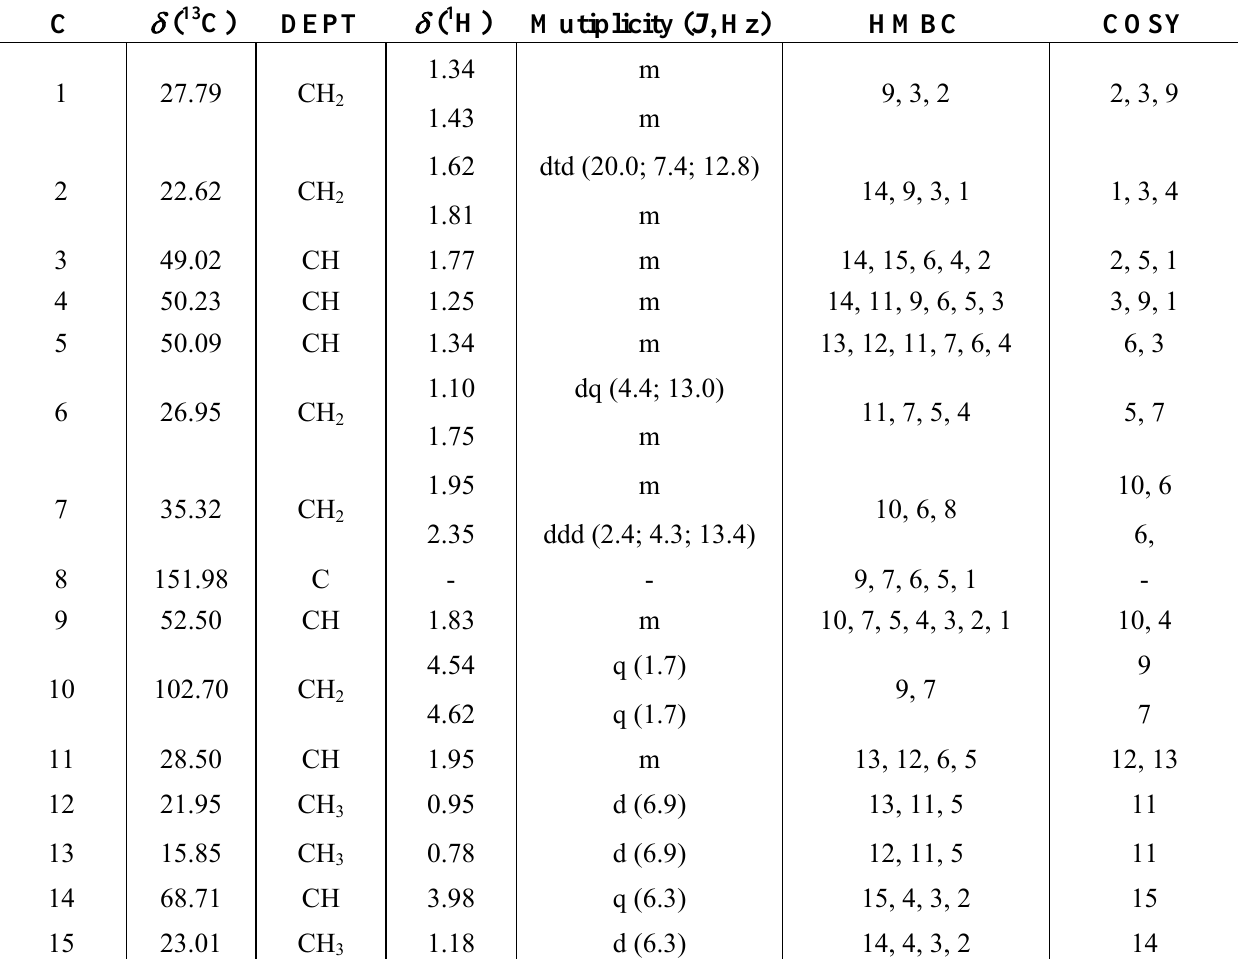
Table 1. 1 H- and 13 C-NMR spectra data, HSQC and HMBC correlations for (14 R )- β -oplopenol ( 1 ).